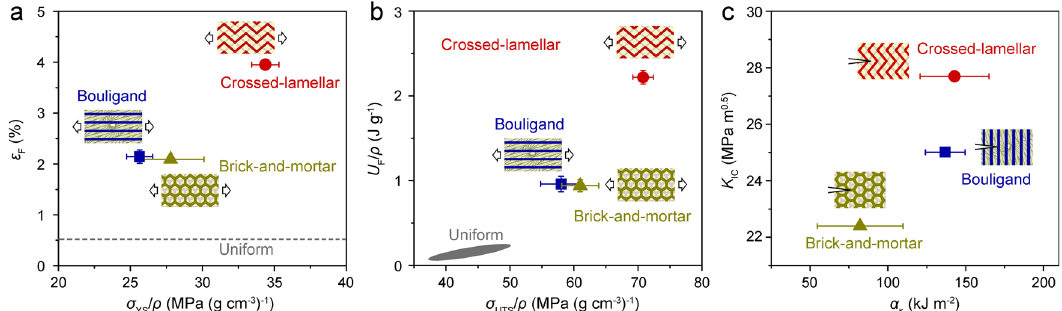
Fig. 7 Comparison of mechanical properties for the bioinspired Mg-Ti composites with different architectures. a Elongation to fracture ε F versus speci fi c yield strength σ YS = ρ ; b speci fi c work of fracture U F = ρ versus speci fi c ultimate tensile strength σ UTS = ρ ; c fracture toughness K Ic versus impact toughness α κ . The loading con fi gurations with respect to the architectures for uniaxial tension, fracture toughness and impact toughness measurements are illustrated in the insets. The data for the Mg alloy composite reinforced with discrete Ti-6Al-4V particles (uniform) are also shown for comparison